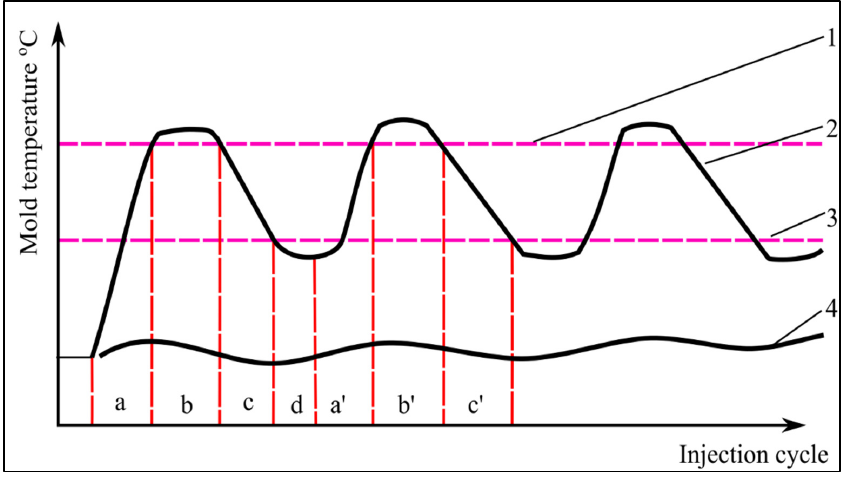
Figure 6. Mold temperature of RHCM technology and conventional injection method [56].